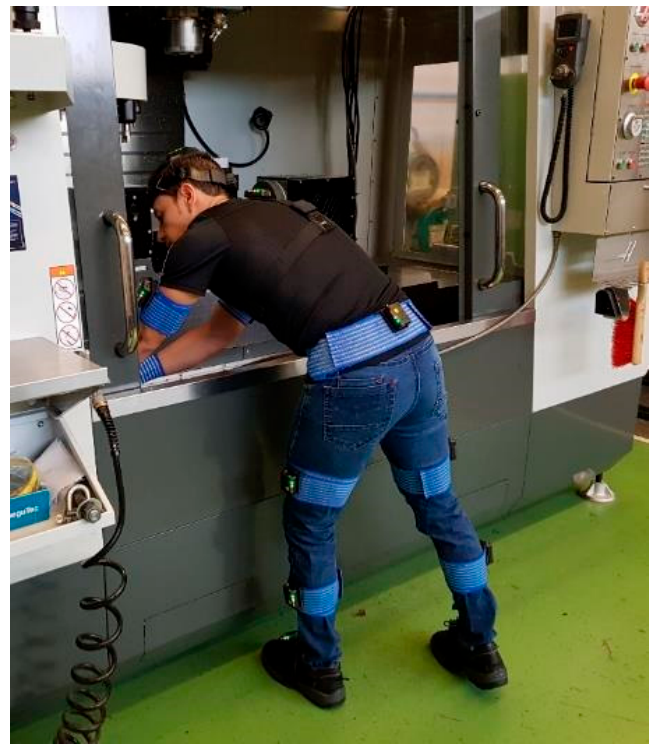
Figure 1. Motion capture in the field, placement of sensors on the worker’s clothing.